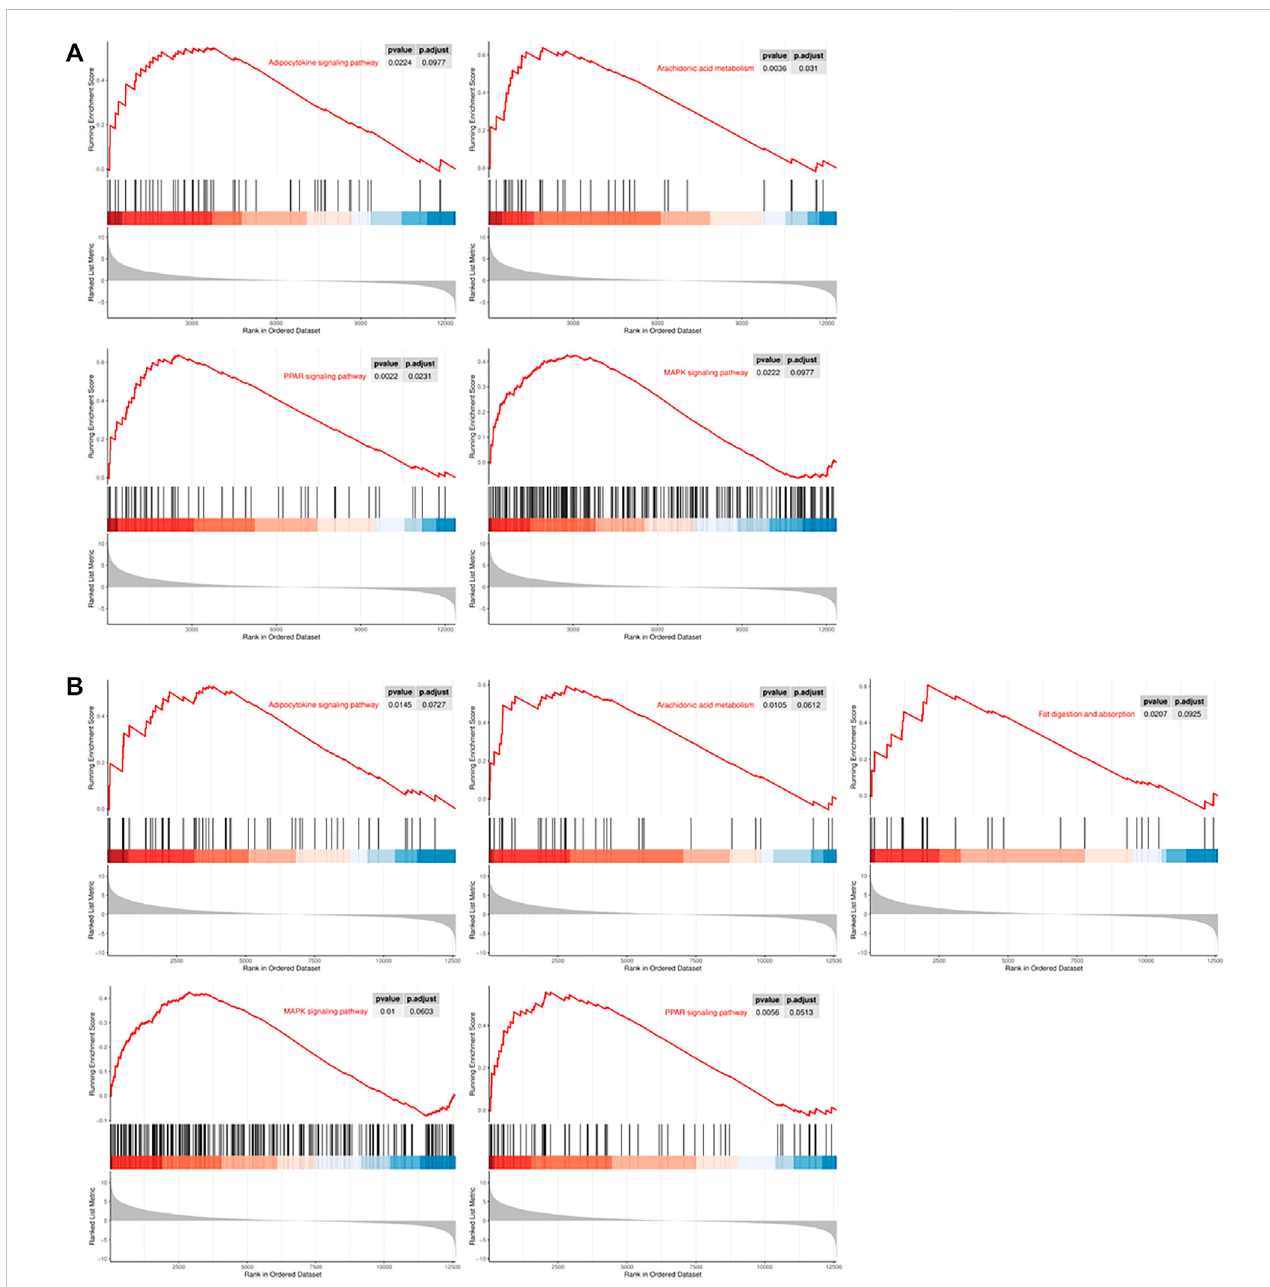
Gene set enrichment analysis (GSEA) of CiADCs-3d/6d revealed several signaling pathways that were either activated (A) CiADCs-3d: adipocytokine, arachidonic acid metabolism, MAPK and PPAR signaling pathway. (B) CiADCs-6d: adipocytokine, arachidonic acid metabolism, fat digestion and absorption, MAPK and PPAR signaling pathway. Color scaled within each row. Red color indicates high expression level, while blue color indicates low expression level.